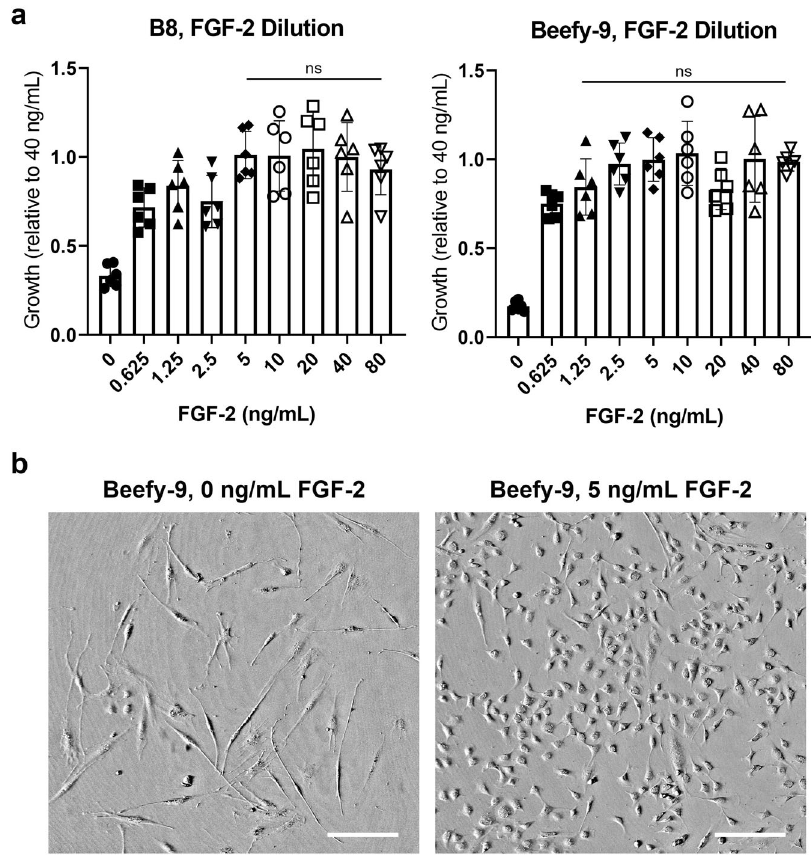
Fig. 4 Short-term growth in B8 & Beefy-9 with reduced FGF-2. a BSC proliferation over 4 days in B8 or Beefy-9 with various concentrations of FGF-2. FGF-2 could be reduced to 5 ng/mL or 1.25 ng/mL in B8 or Beefy-9, respectively, without signi fi cantly impacting cell growth over four days. n = 6 distinct samples; statistical signi fi cance was calculated by one-way ANOVA with multiple comparisons between various FGF-2 concentrations and 40 ng/mL control conditions. Lack of signi fi cance between samples is indicated by ‘ ns ’ across all samples that hold no signi fi cant difference from 40 ng/mL). b Bright fi eld images of BSCs grown for three days in Beefy-9 media with 0 or 5 ng/mL FGF-2. Images show that the complete removal of FGF-2 from Beefy- 9 signi fi cantly affects satellite cell morphology, whereas a reduction to 5 ng/mL did not affect morphology as compared with images in Figs. 1 and 2. Scale bars are 200 μ